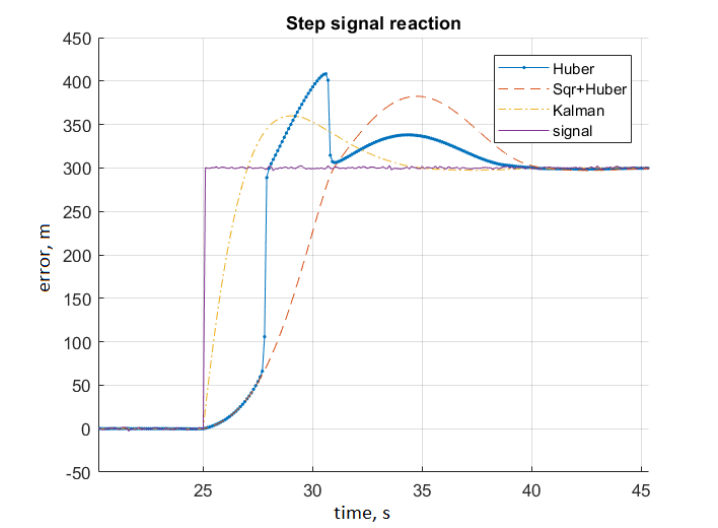
Figure 1. Transients for different filtering